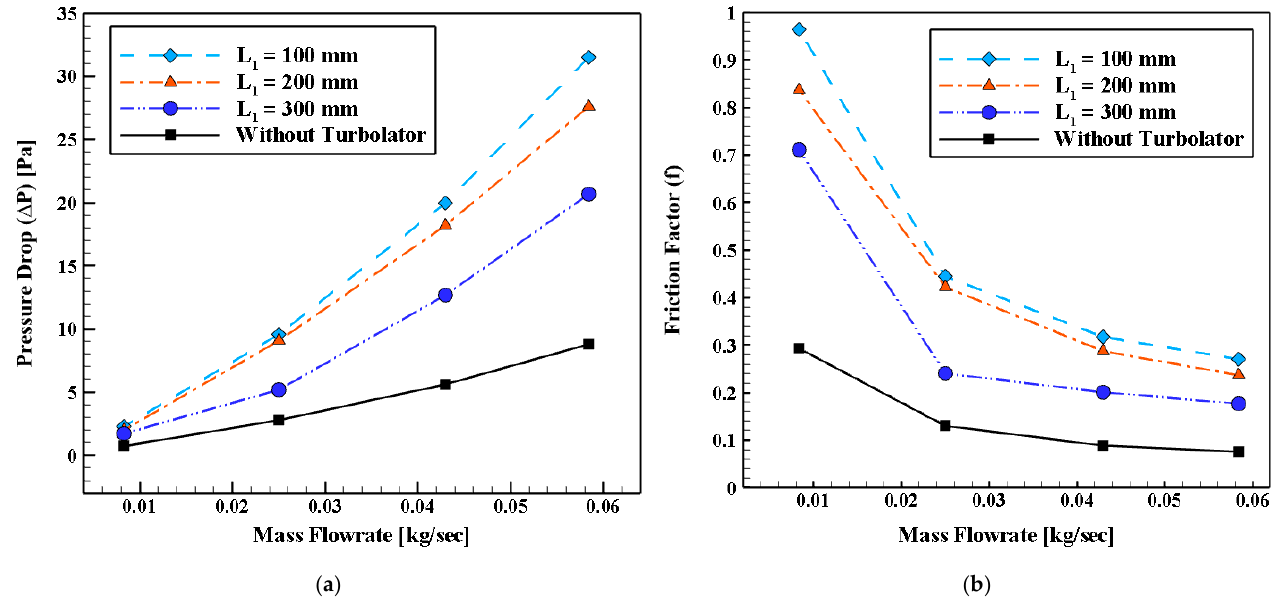
Figure 10. The deviations of ( a ) pressure loss and ( b ) friction factor versus the mass flow rates for various lengths of swirl generator at n = 12, θ = 180 degrees, and S = 0.3 π mm.